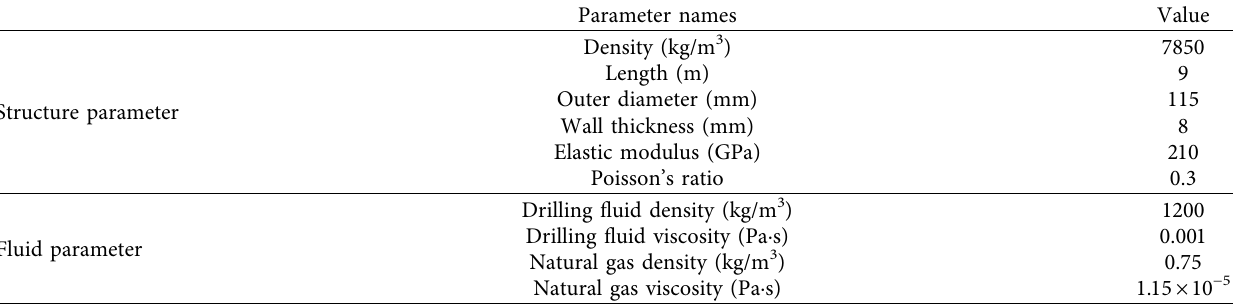
Table 1: Fluid and structure parameters.